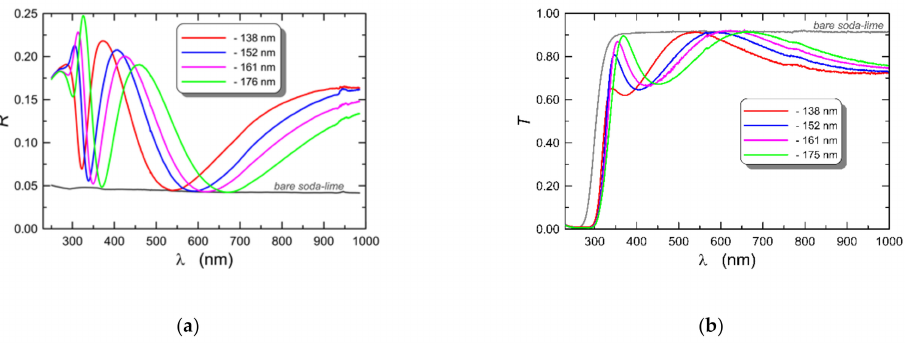
Figure 11. Experimentally measured reflectance ( a ) and transmittance ( b ) spectra for selected silica– titania films on soda-lime glass